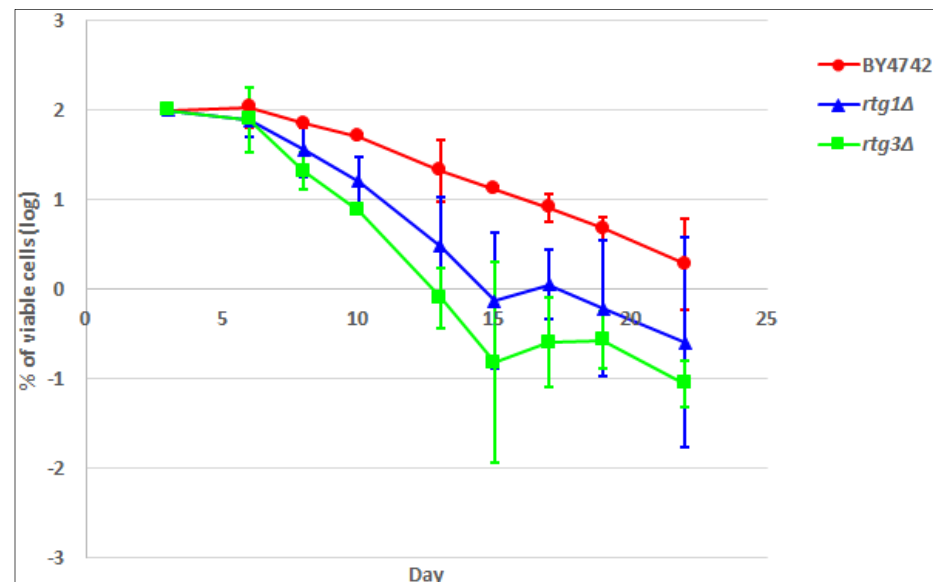
Figure 5. The chronological lifespan (CLS) of BY4742, rtg1 ∆ and rtg3 ∆ , measured as the number (log %) of viable cells in exhausted growth media after revival on YPD (1% yeast extract, 2% peptone, 2% dextrose, 2% agar (% w/v )) plates. CLS at Day 3 (start of the stationary phase) was defined as